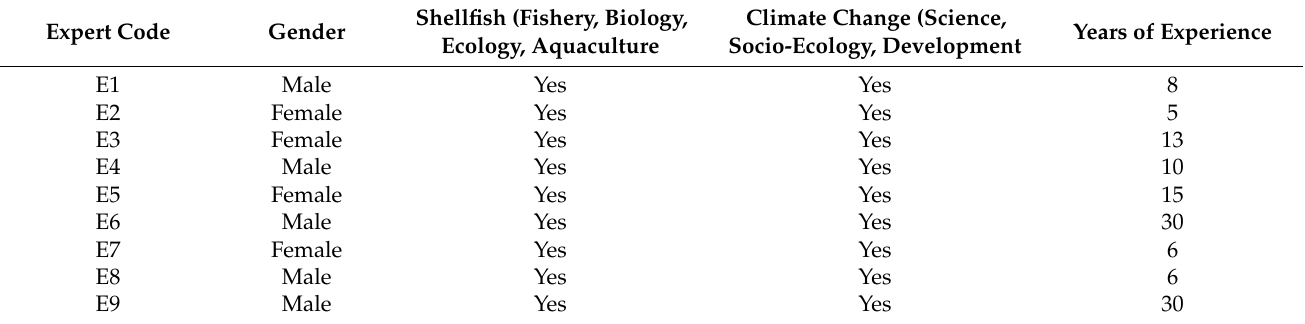
Table 1. Summary of background of experts.